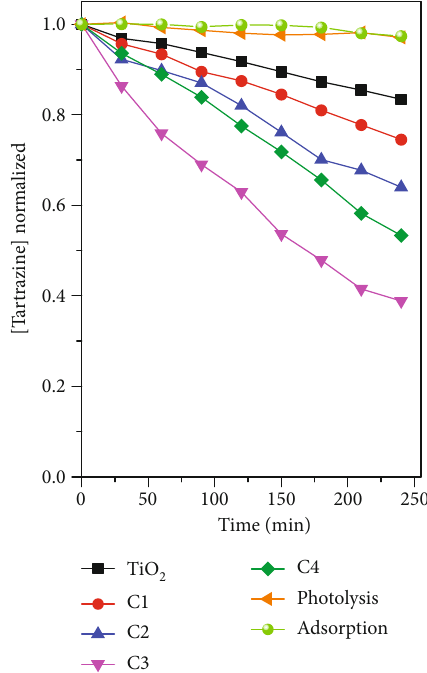
Figure 8: Degradation curves of azo tartrazine dye from solar